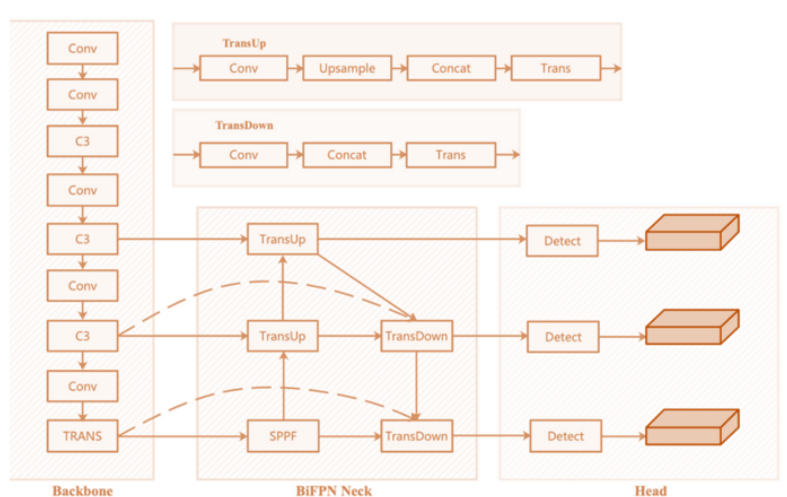
Figure 12. Architecture of